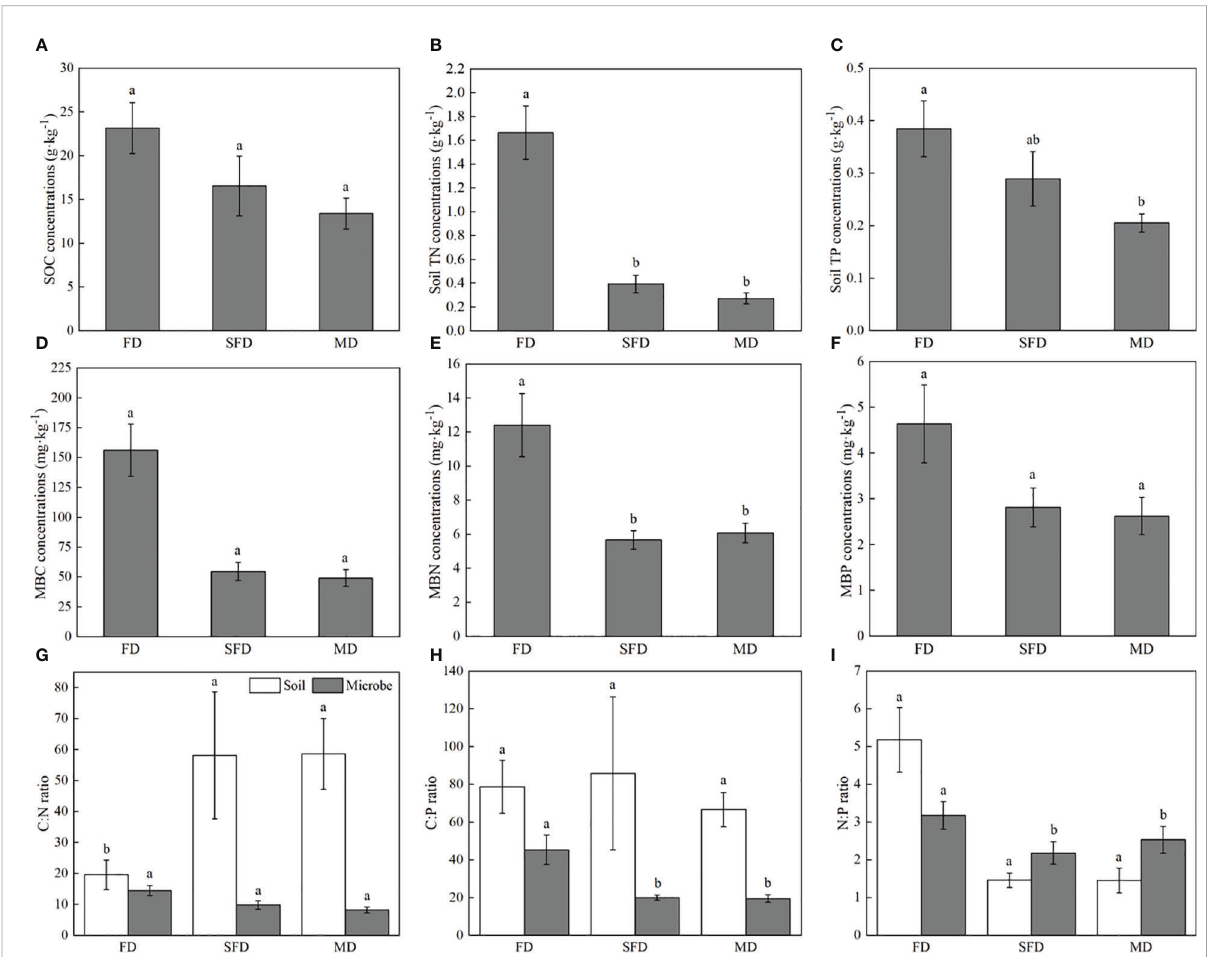
FIGURE 2 C, N, and P concentrations and stoichiometry in soils and microbes of Sophora moorcroftiana population in 0 – 20 cm soil layer under different sandy dune types. C, N, and P concentrations in soils (A – C) and microbes (D – F) . C, N, and P stoichiometry (G – I) in soils and microbes. Different lowercase letters indicate a signi fi cant difference under different sandy dune types (P < 0.05). FD, fi xed dune; SGL, sandy gravel land; SFD, semi fi xed dune; MD, moving